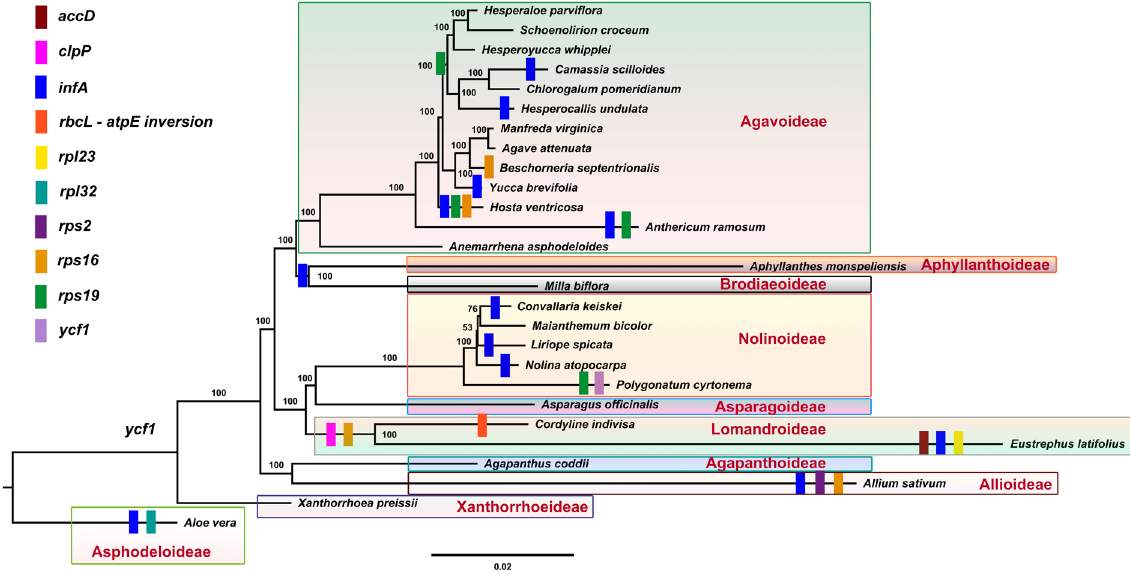
Figure 3. Molecular phylogenetic tree of 27 Asparagales taxa based on 68 protein-coding genes in the chloroplast genome. The tree was constructed by maximum likelihood analysis of the conserved regions using the RAxML program and the GTR + G + I nucleotide model. The stability of each tree node was tested by bootstrap analysis with 1,000 replicates. Bootstrap values are indicated on the branches, and the branch length reflects the estimated number of substitutions per 1,000 sites. Aloe vera and Xanthorrhoea preissii were set as the outgroups.